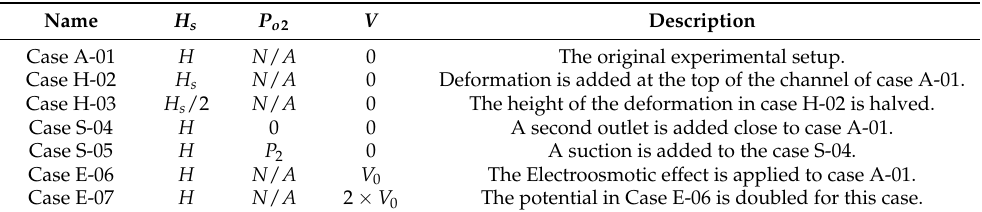
Table 3. Difference of the setups; original experimental setup (case A-01), thin chamber (series H-02), the thin chamber with half-height (case H-03), second outlet with zero pressure (case S-04), suction (case S-05), electroosmotic flow (cases E-06 and E-07). Name H s P o 2 V 0 The original experimental setup. Case H-02 H s N / A 0 Deformation is added at the top of the channel of case A-01. Case H-03 H s /2 N / A 0 The height of the deformation in case H-02 is halved. Case S-04 H 0 0 A second outlet is added close to case A-01. Case S-05 H P 2 0 A suction is added to the case S-04. Case E-06 H N / A V